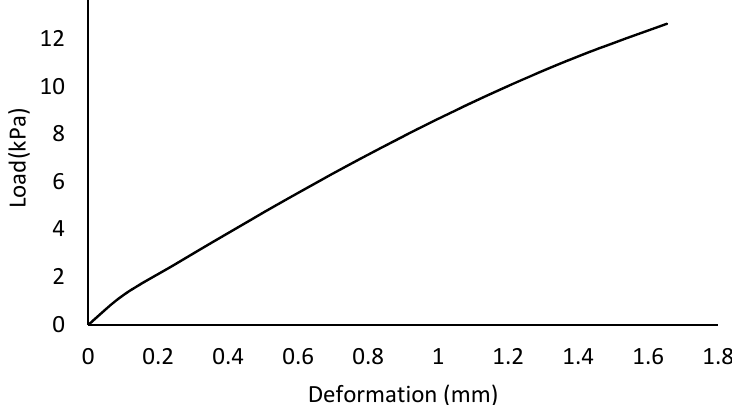
Figure 37. Deflection at the midpoint of the primary folding link bar assembly.